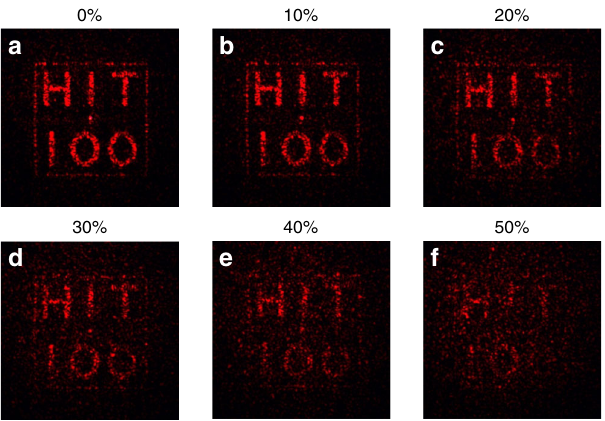
Fig. 3 The vulnerable test of the meta-hologram. From a – f , the mismatch ratio of the incident light increases from 0 to 50% with a step of 10%.